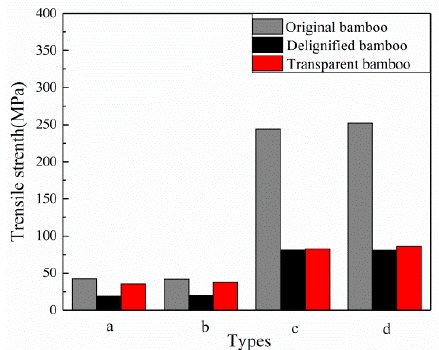
Figure 9. Comparison of the maximum tensile strength values in different samples. (a) IB; (b) HIB; (c) OB; (d) HOB.